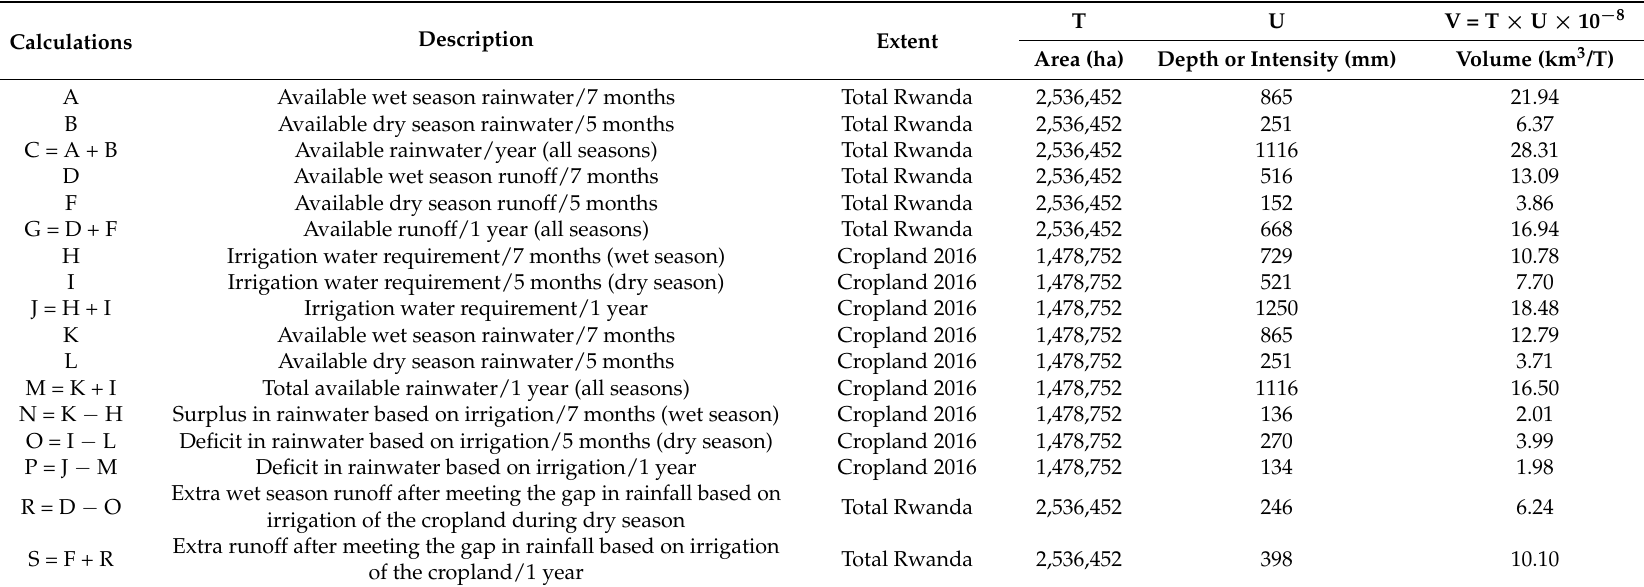
Table 7. Analysis of wet season runoff reservation for cropland irrigation during the dry season in Rwanda.